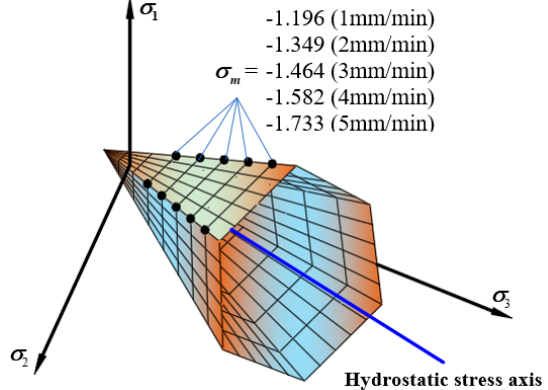
different temperatures. di ff erent temperatures. Materials 2020 , 13 , x FOR PEER REVIEW